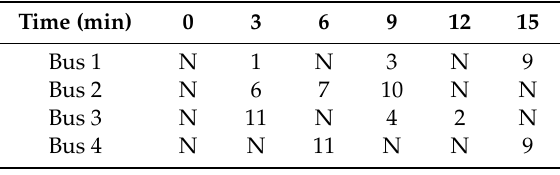
Table 4. Bus travel times and relative stops.